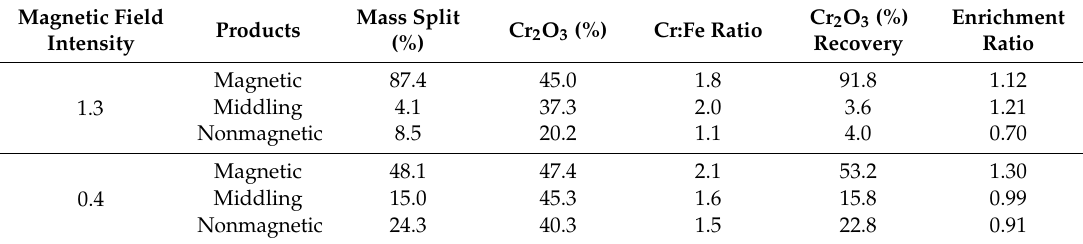
Table 9. Results of the two-stage separation in the WHIMS for the ultrafine